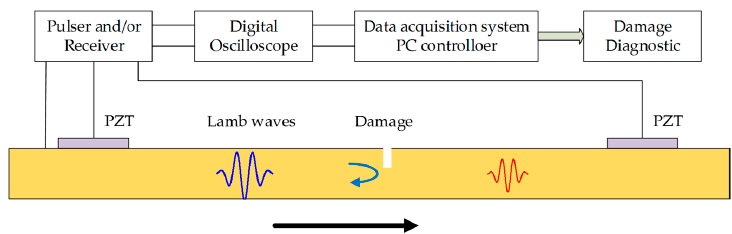
Figure 11. Experimental setup for the damage detection technique.